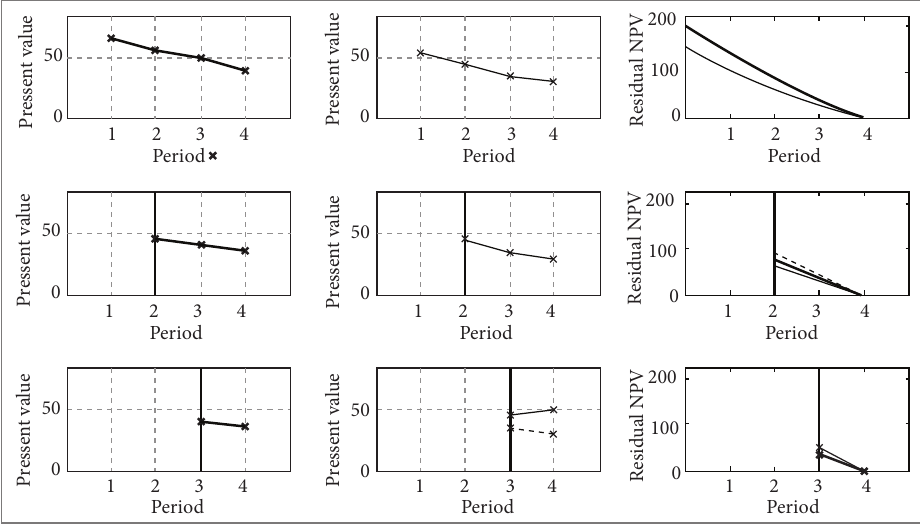
Fig. 7. Ideal-typical example of low agent switching costs and private information about the suppliers’ maximal bids, present values of both suppliers (left, middle columns) and comparison of residual net present values (right column), suddenly changed situations because of 2 shocks in the 2 nd and 3 rd rounds (middle, lower